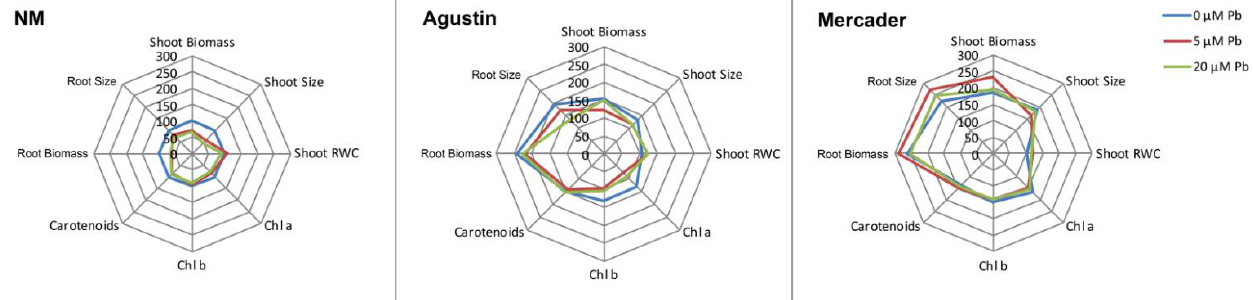
Figure 1. Radar chart of the effects of Pb treatments [0, 5 and 20 µM Pb(NO 3 ) 2 ] for 4 weeks on growth parameters (shoot and root biomass, shoot and root size), RWC and photosynthetic pigment levels of seedlings from non-mining (NM) and mining (Agustin and Mercader) Z. fabago populations exposed to 0, 5 and 20 µM Pb(NO 3 ) 2 for 4 weeks. Parameters values of M populations are expressed as percentage of the corresponding non Pb-treated NM value.